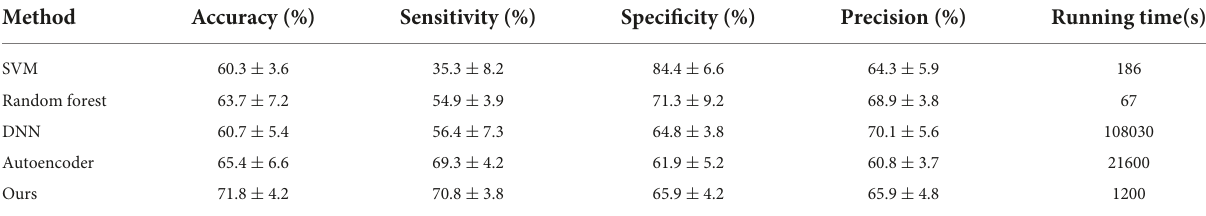
TABLE 2 Classification performance of different methods on multi-centers dataset.